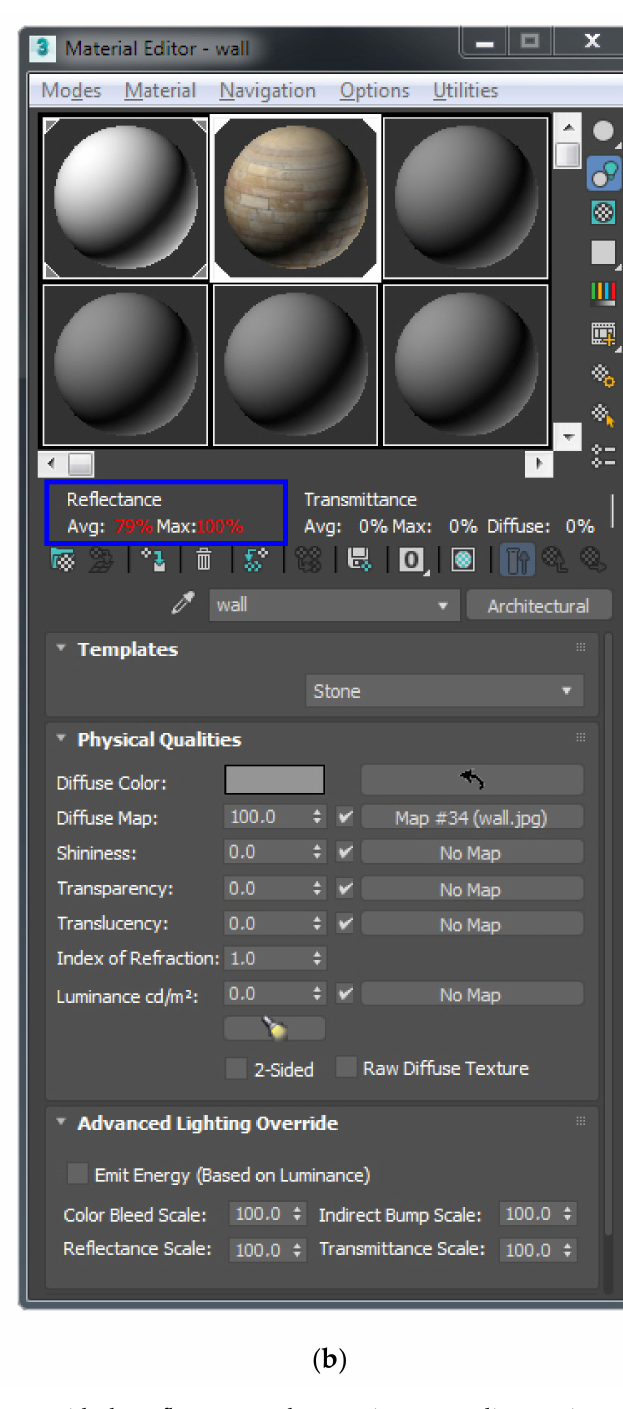
Figure 13. Material Editor of Autodesk 3ds Max 2021 software with the reflectance and transmittance reading section highlighted: ( a ) material defined as a white bitmap and ( b ) material defined by means of a multicolour